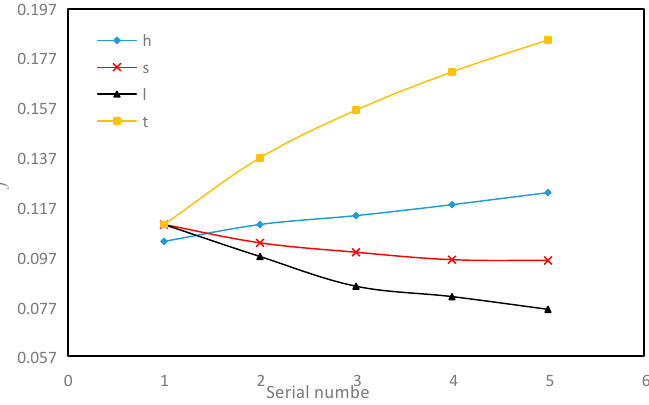
Figure 15. E ff ect of fi n structure parameter on f factor.